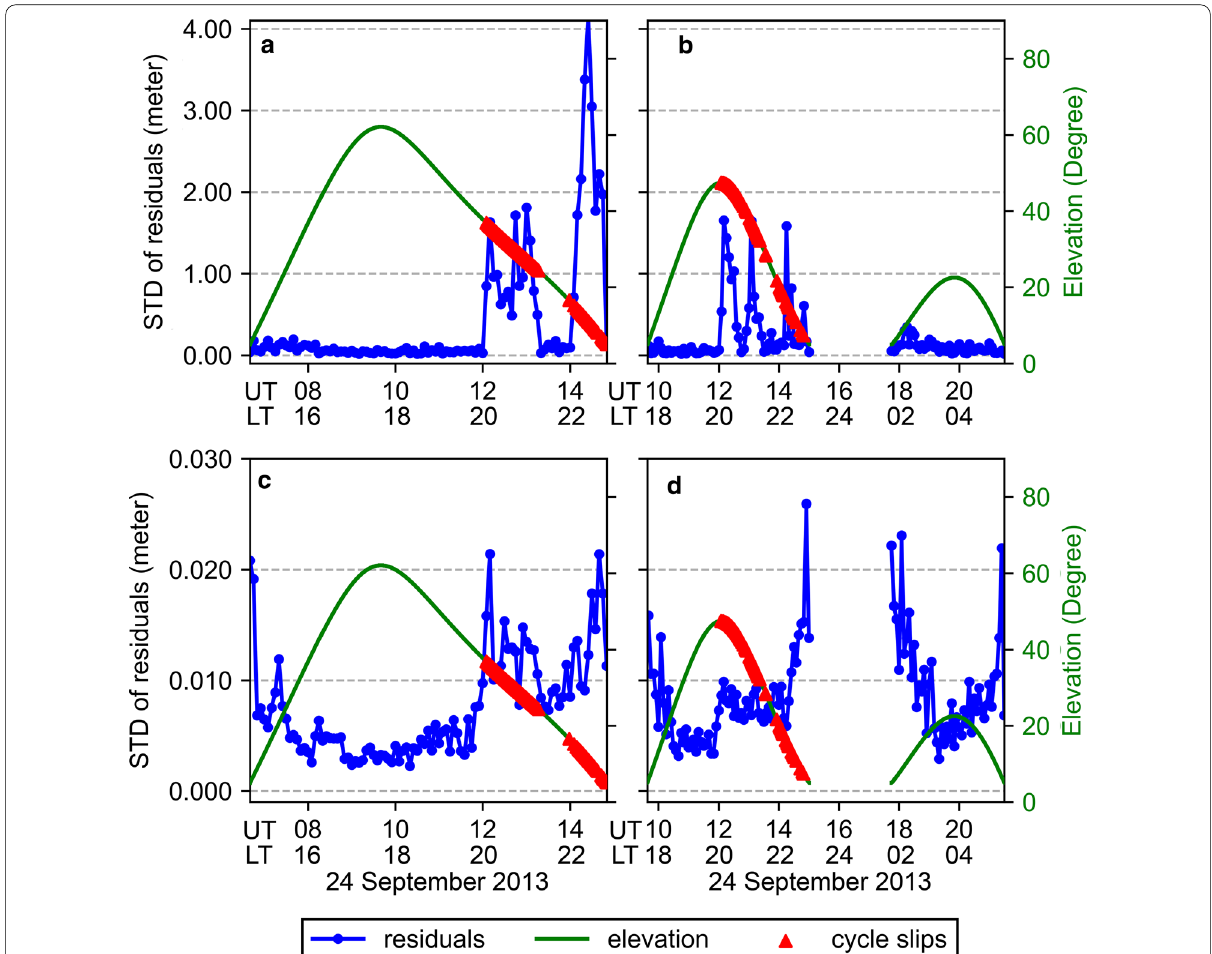
Fig. 13 STD of residuals of ionosphere-free measurements on pseudorange and carrier phase for GPS PRN 5 ( a , c ) and GPS PRN 29 ( b , d ) at the site of HKPC on 24 September 2013, along with the elevation and cycle slip information. The blue line with circles denotes STD of the residual for every 5 min; the green lines denote the elevation angle; the red triangles represent cycle